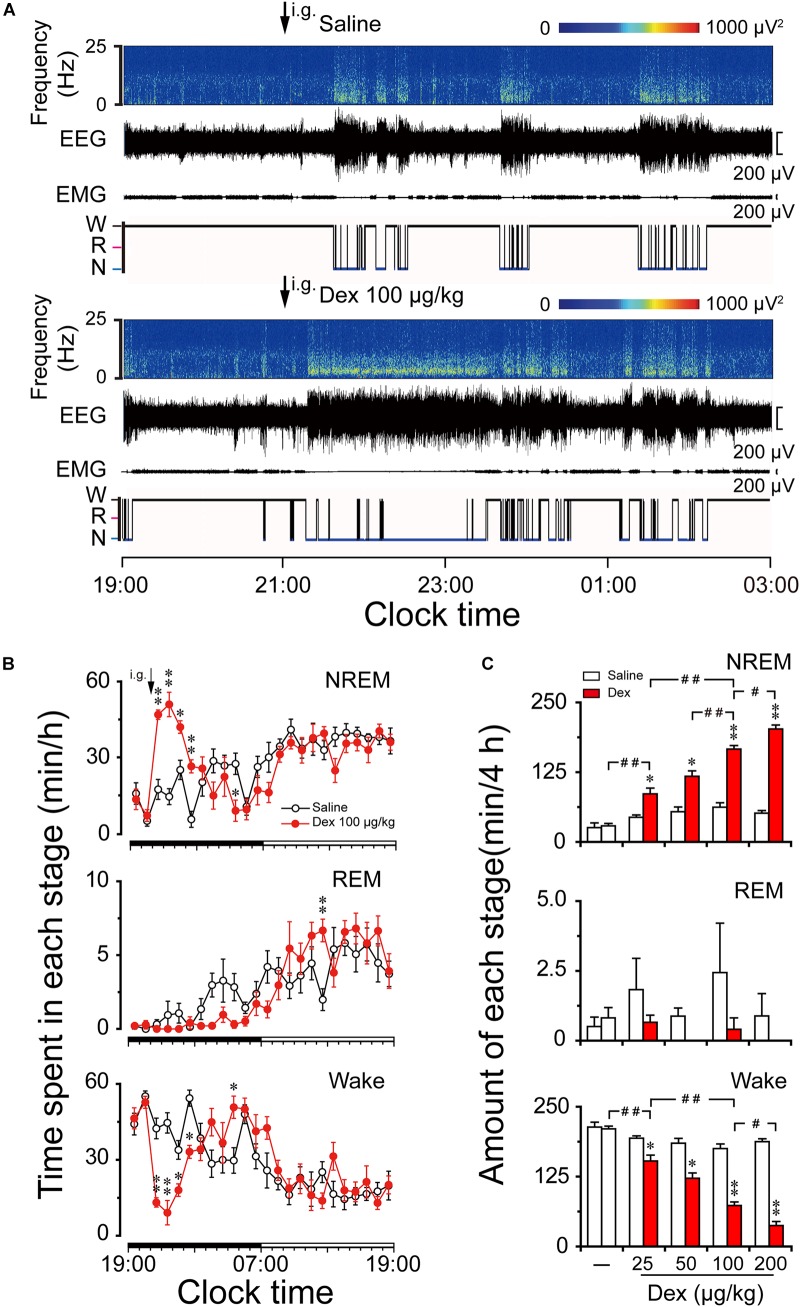
Effects of dexmedetomidine on sleep-wake profiles in mice during the dark phase. (A) Typical examples of compressed spectral array (0–25 Hz) EEG, EMG, and hypnograms over 8 h (19:00–03:00) following saline (upper panel) or dexmedetomidine 100 μg/kg (lower panel) administration. (B) Time course changes in NREM sleep, REM sleep, and wakefulness following saline (open circle) and dexmedetomidine (100 μg/kg, i.g.; closed red circle) administration during the dark phase. Each circle represents the hourly mean amount of each stage. The horizontal filled and open bars on the X-axes indicate the 12-h dark and 12-h light periods, respectively. Values are means ± SEM (n = 6); ∗P < 0.05 and ∗∗P < 0.01 indicate significant differences compared with their own control as assessed by two-way repeated measures ANOVA followed by Bonferroni tests. (C) Dose-response effects on total time spent in NREM sleep, REM sleep, and wakefulness for 4 h after administration of saline and dexmedetomidine in mice. Open and red filled bars show the profiles of saline and dexmedetomidine treatment, respectively. Values are the means ± SEM (n = 6). ∗P < 0.05 and ∗∗P < 0.01 indicate significant differences compared with their own control as assessed by two-tailed paired Student’s t-test. #P < 0.05 and ##P < 0.01 indicate significant differences between saline and different doses of dexmedetomidine as assessed by one-way ANOVA followed by Bonferroni tests.